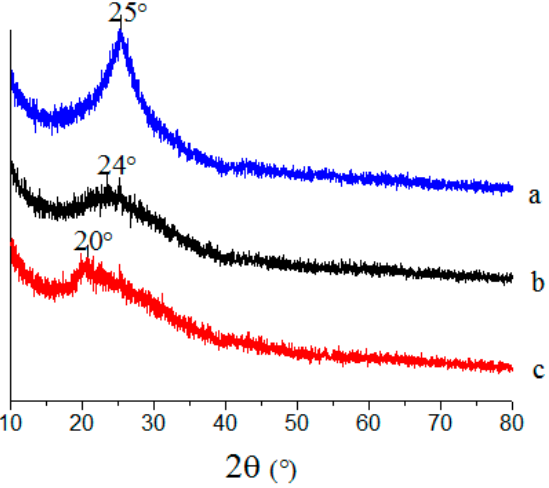
Figure 4. XRD patterns of aerogels: ( a ) GO, ( b ) CS/GO, and ( c ) CS.